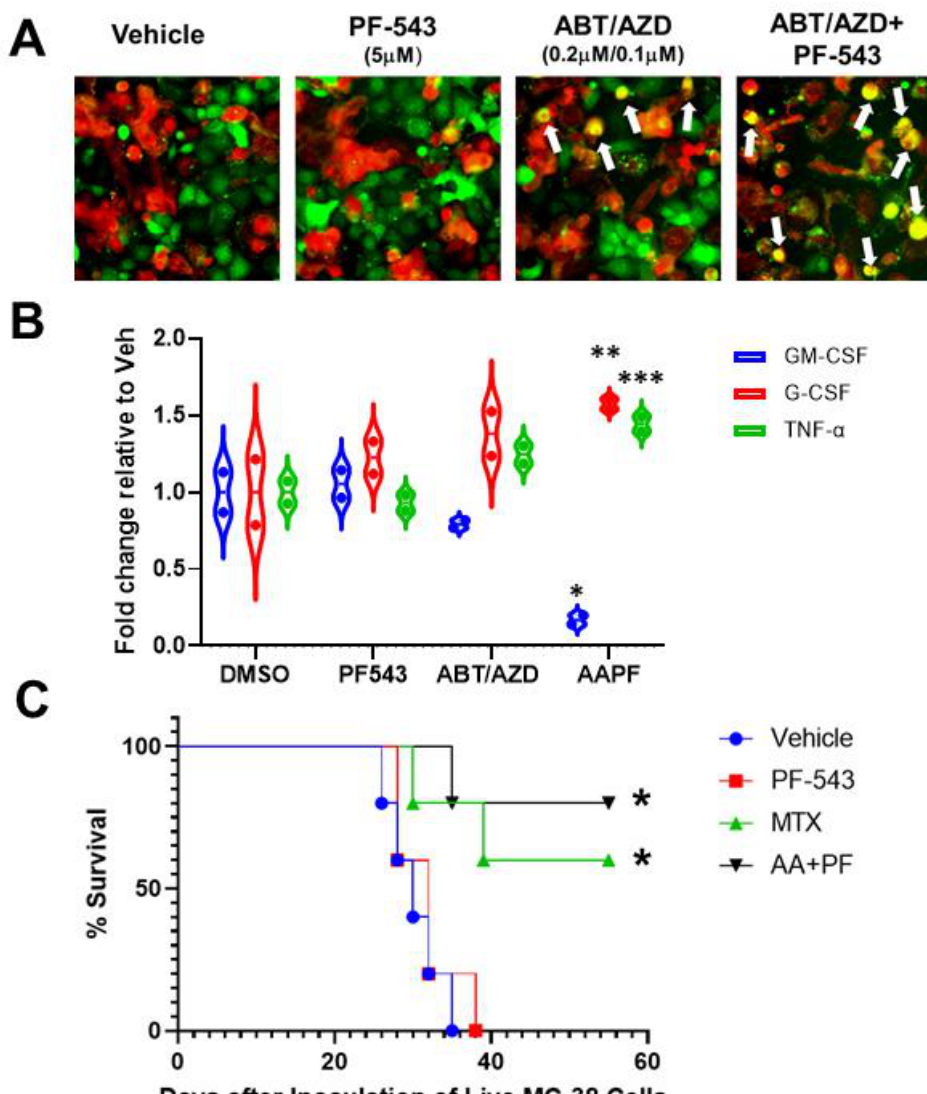
Figure 9. In vitro and in vivo demonstration of induction of ICD by ABT/AZD + PF-543. ( A ). In vitro phagocytic activity assays using THP-1 differentiated M1 macrophages. Representative images of M1 macrophages (red) co-cultured with DLD-1 cells (green) treated as indicated for 24 h White arrows show co-localization of red and green indicative of M1 macrophage engulfment of DLD-1 cells treated with ABT/AZD and ABT/AZD + PF-543. ( B ). Conditioned media from M1 macrophages/DLD1 cells co-culture as described in A were collected and analyzed for expression levels of cytokines associated with ICD. Statistical analysis was performed using one-way ANOVA followed by Tukey’s multiple comparison test. (* p ≤ 0.05, ** p ≤ 0.01, *** p ≤ 0.001) Asterisks indicate significant changes as reported in results section. ( C ). In vivo vaccination assay demonstration of ICD. Mice ( n = 6/group) were initially vaccinated with 1.0 × 10 6 injured/dead MC-38 cells treated with mitoxantrone (MTX; 0.3 µ M) alone or the combination of ABT/AZD + PF-543 (AA + PF; 0.06 µ M/0.13 µ M/2.5 µ M) for 24 h. Vehicle control cells were subjected to repeated freeze/thaw cycles. 1 week later, vaccinated mice were challenged with live 4.0 × 10 5 MC-38 cells that were transduced with luciferase, by injection into the contralateral flank. Kaplan–Meier survival curves for mice were generated. Statistical analysis was performed using Log-rank (Mantel-Cox) tests.